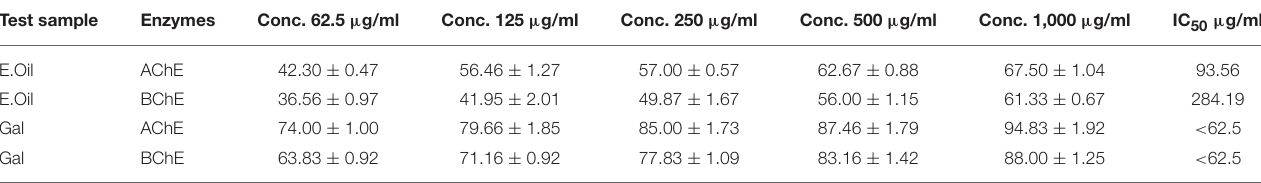
TABLE 6 | Anticholinesterase activity of essential oil of Isodon rugosus at various concentrations. Test